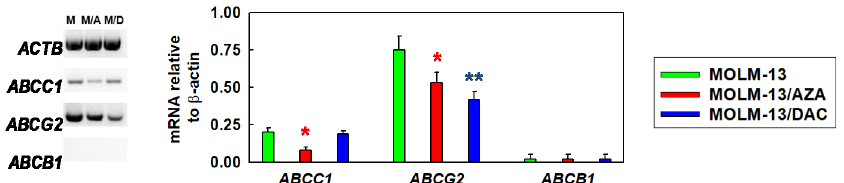
Figure 2. Expression of ABC (ATP-binding cassette) transporters in MOLM-13, MOLM-13/AZA, and MOLM-13/DAC cells as determined by RT-PCR. Electrophoretic gels were quantified by densitometry and summarized in column plots. The gel is representative of three independent measurements. The data in the column plot represent the mean ± SD of three independent measurements. Significance: * = p <0.05; ** = p <0.02.